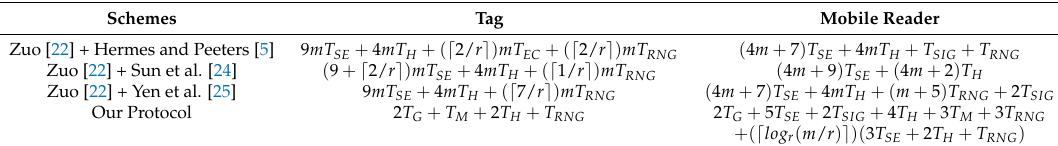
Table 4. Computational